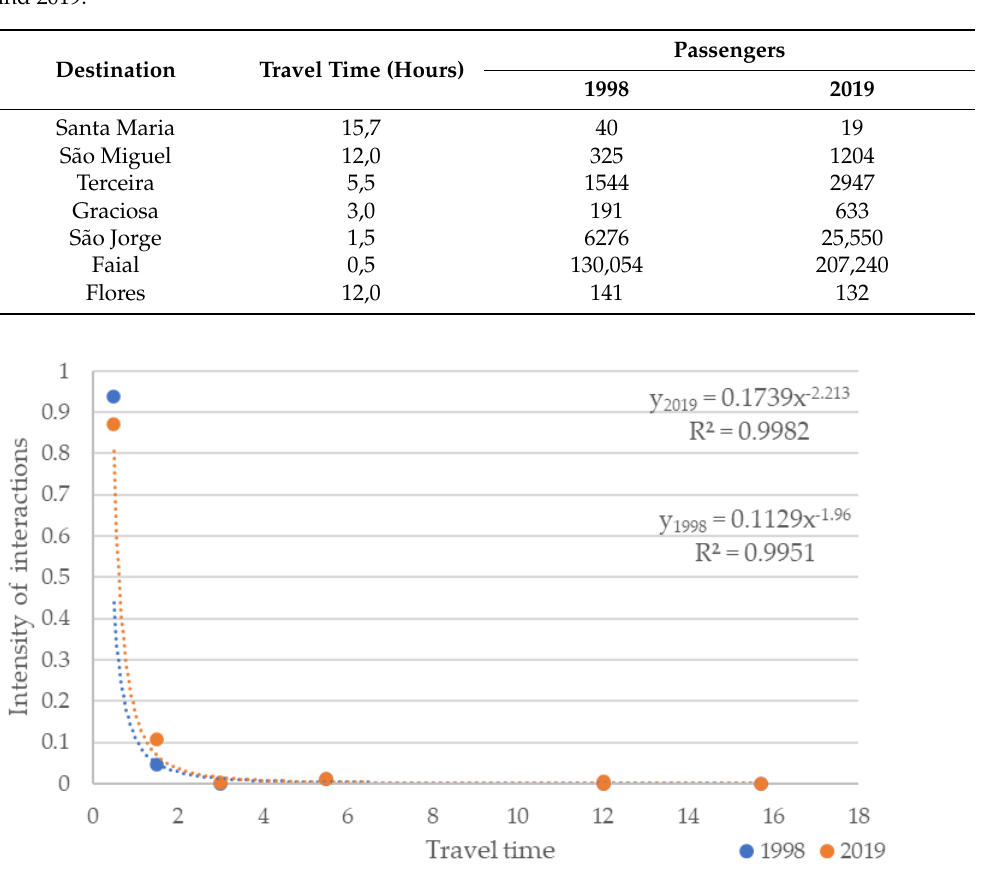
Figure 3. Intensity of interactions and travel time to Pico Island from the rest of the archipelago—for 1998 and 2019.